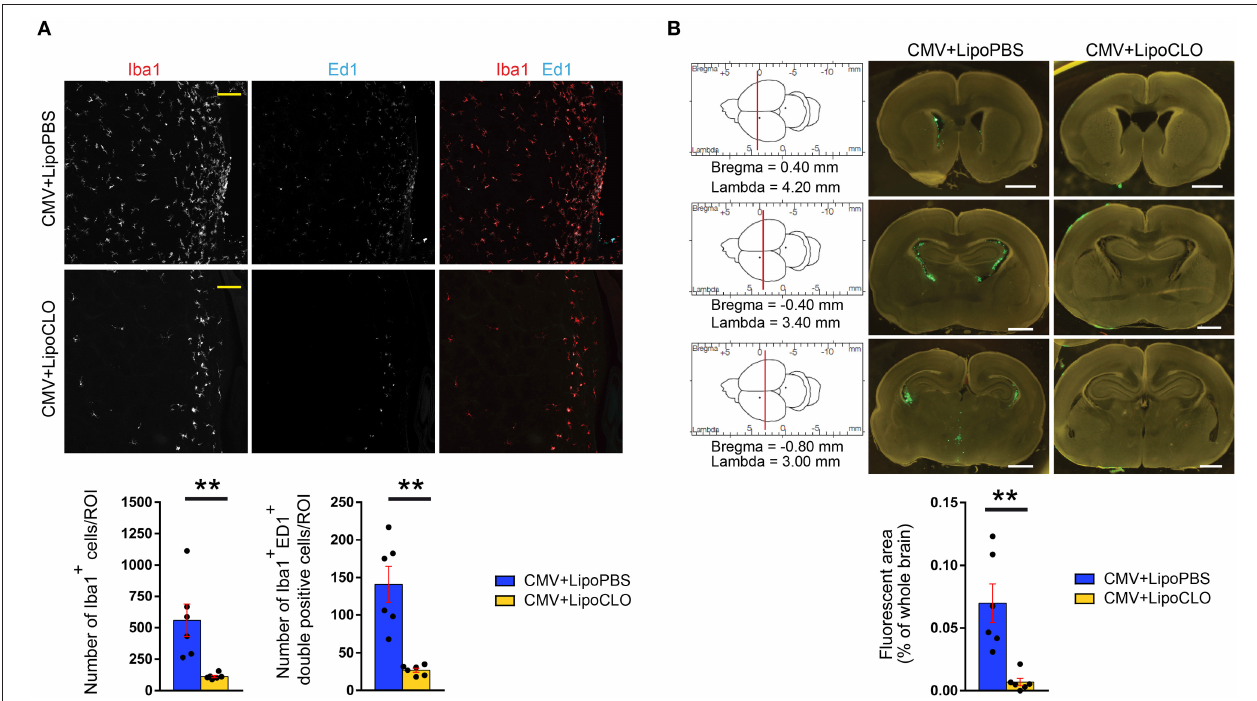
FIGURE 3 | Clodronate liposomes deplete microglia and reduce CMV spreading in the developing brain. Recombinant rat CMV allowing expression of GFP (green) in the infected cells was injected icv in rat embryos at E15 together with either clodronate liposomes (LipoCLO) to deplete microglia, or PBS liposomes (LipoPBS) as control. (A) LipoCLO decreased the number of Iba1 + microglia (red) and of Iba1 + , Ed1 + (cyan) phagocytically active microglia. Three to four adjacent coronal brain sections were analyzed by confocal microscopy throughout the entire z-dimension ( n = 6 brains in each condition). ROI: region of interest (775 × 775 µ m 2 ). Bar: 100 µ m. Mann-Whitney test, two-tailed, with Bonferroni correction. ** p < 0.005. (B) LipoCLO reduced rat CMV infection of the brain. Brains were analyzed at P1 using fluorescent binocular microscopy. Three sections were selected according to their coordinates in the rostrocaudal axis (left). CMV infection